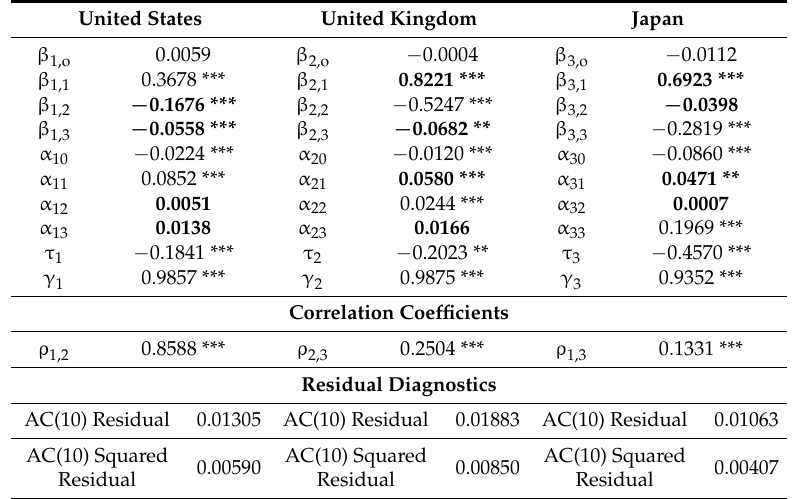
Table A7. Estimation from the multivariate MVR-EGARCH model (conventional equities—crisis). United States United